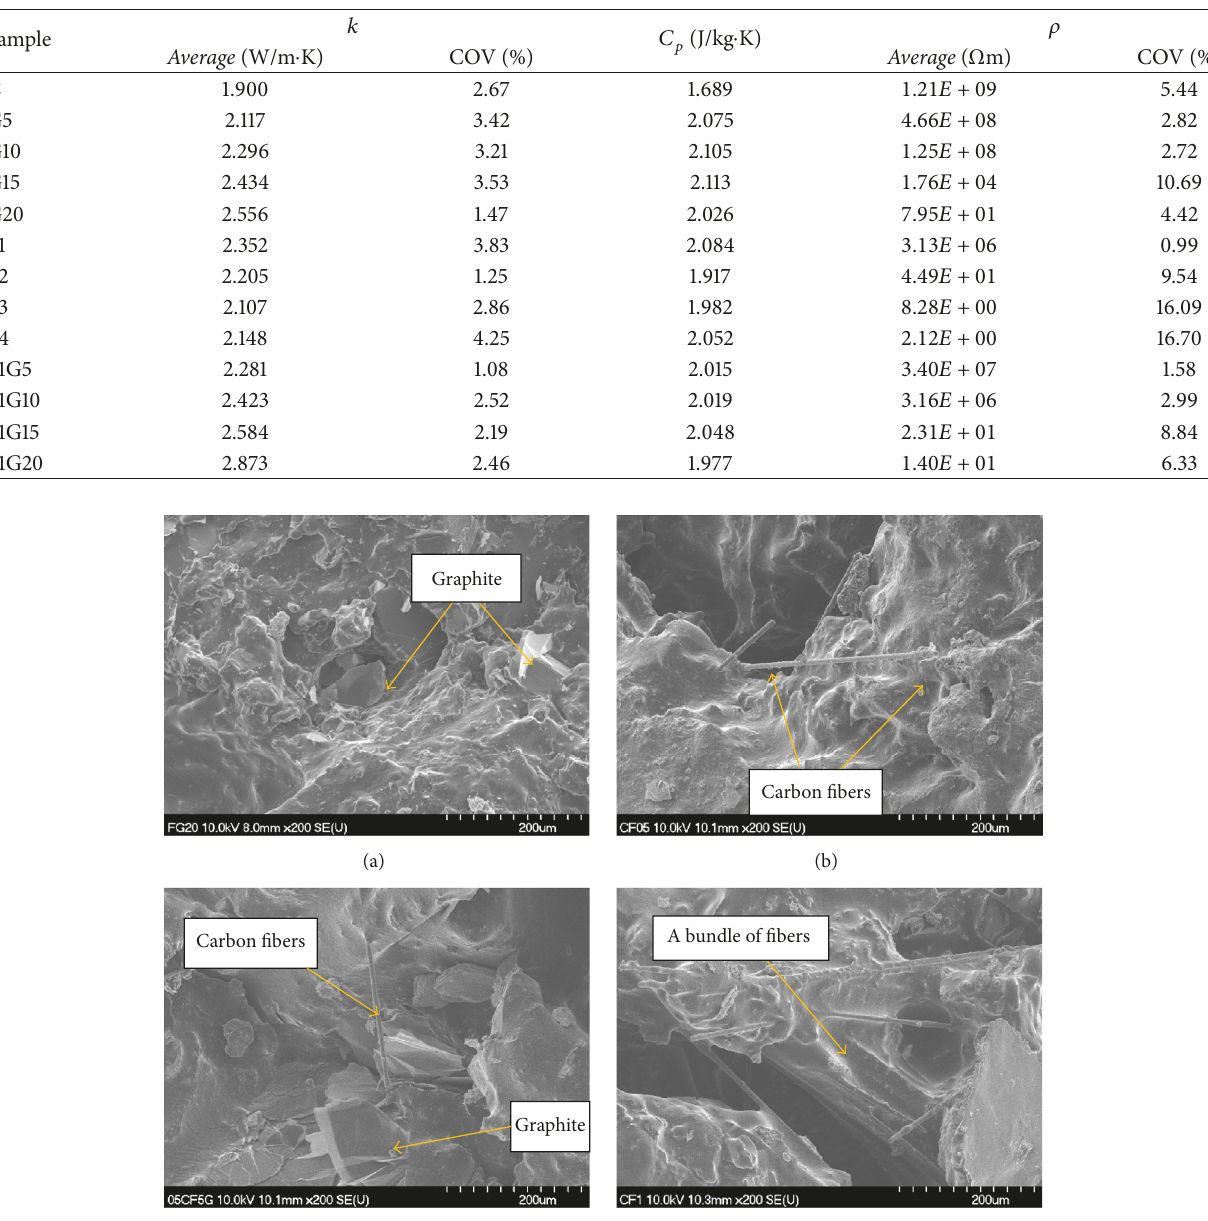
Table 2: Summary of thermal conductivity, thermal capacity, and electrical resistivity results.